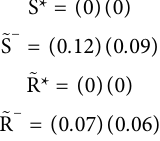
alternatives, and the opinion from the fi ve DMs, a single measurement for the best strategies to enhance water supply